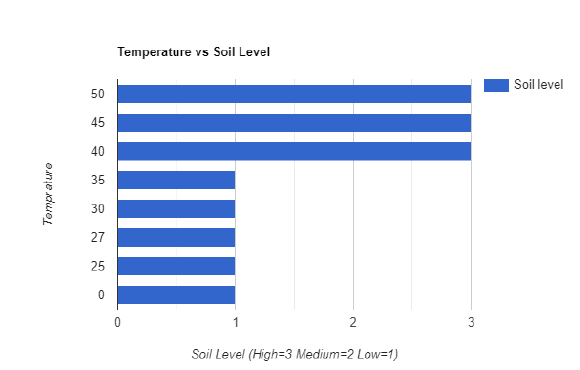
Fig4.(d)Graph of temprature vs Soil level